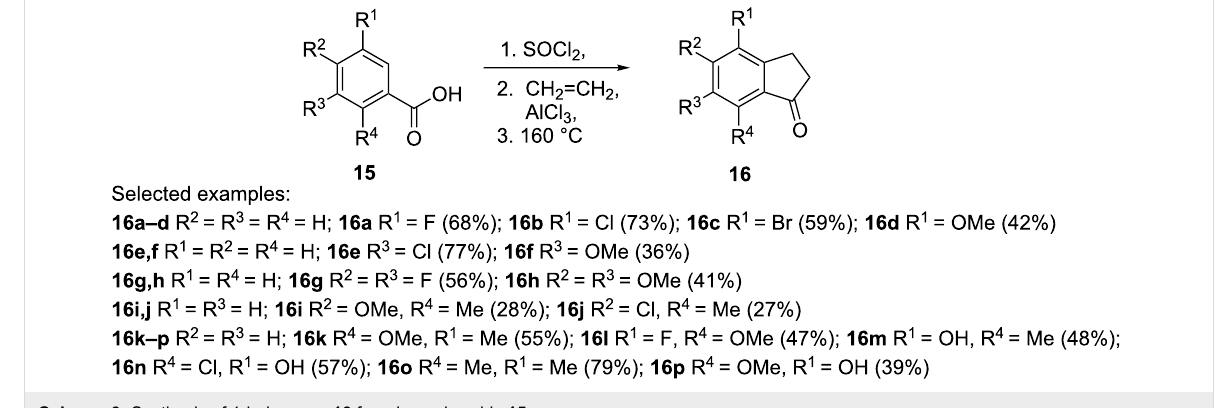
Scheme 6: Synthesis of 1-indanones 16 from benzoic acids 15 .